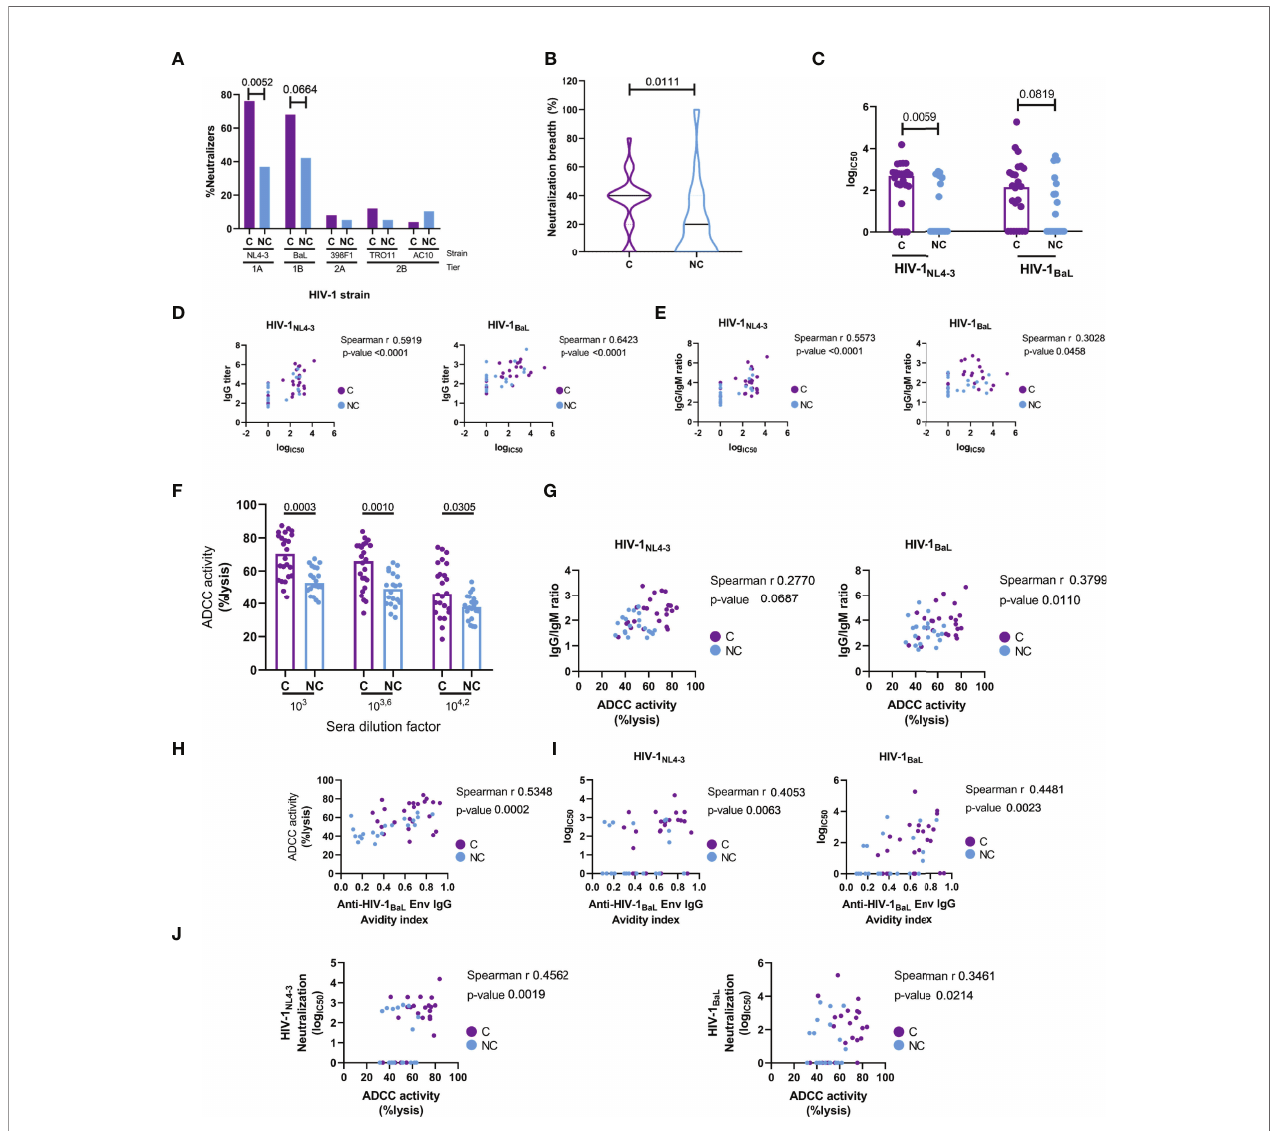
FIGURE 6 | Antibody mediated anti-HIV functional responses. Responses are compared between controllers ( (C) , purple) and non-controllers (NC, light blue). (A) Percentage of individuals capable to neutralize a panel of 5 HIV-1 pseudoviruses, including 5 strains from tier 1A (NL4-3), 1B (BaL), 2A (398F1) and 2B (TROll and AClO). (B) Neutralizing breadth (left) in HIV+ controllers (C) and non-controllers (NC) calculated as: number of pseudovirus neutralized/number of pseudovirus evaluated (5) *100. (C) IC50 neutralizing capacity of HIV+ controllers (C) and noncont rollers (NC) against HIV-1NL4_3 (left) and HIV-18aL (right). (D) Spearman correlation of logiC50 neutralizing capacity with lgG titers. (E) Correlation of logiC50 neut ralizing capacity with lgG/IgM ratio. (F) Ant ibody-dependent ce llular cytotoxicity (ADCC) induced by t he presence of serial sera dilutions from cont rollers (C) and non-cont rollers (NC). (G) Correlation between ADCC at 1:104·2 serum dilution with lgG/IgM ratio. (H) Correlation between ADCC at 1:10 4.2 serum dilution with avidity index. (I) Correlations between IC50 neutralizing capacity against HIV-1NL4_3 (left) and HIV- 18aL (right) with avidity. (J) Correlation between ADCC at 1:10 4.2 serum dilution with neutralization log(IC50). Statistical signi fi cance of the presence of neutralizing activity (A) in both groups was evaluated by Chi-square, while comparison of medians (B, C and F) was det ermined by non-parametric Mann-Whitney test . Correlations were performed by non-parametric Spearman r test, rho and p-values are displayed in the correspondent